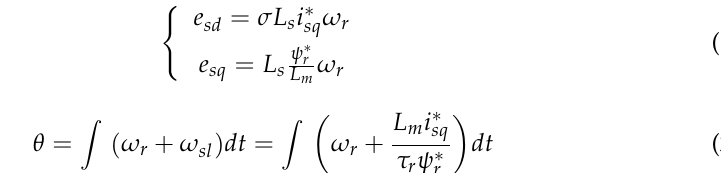
Figure 4. Post-fault control scheme of rotor flux oriented control based on PI resonant (PR) controller.